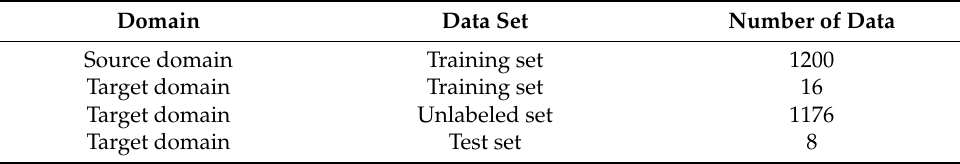
Table 1. Source/Target domain data classification table.